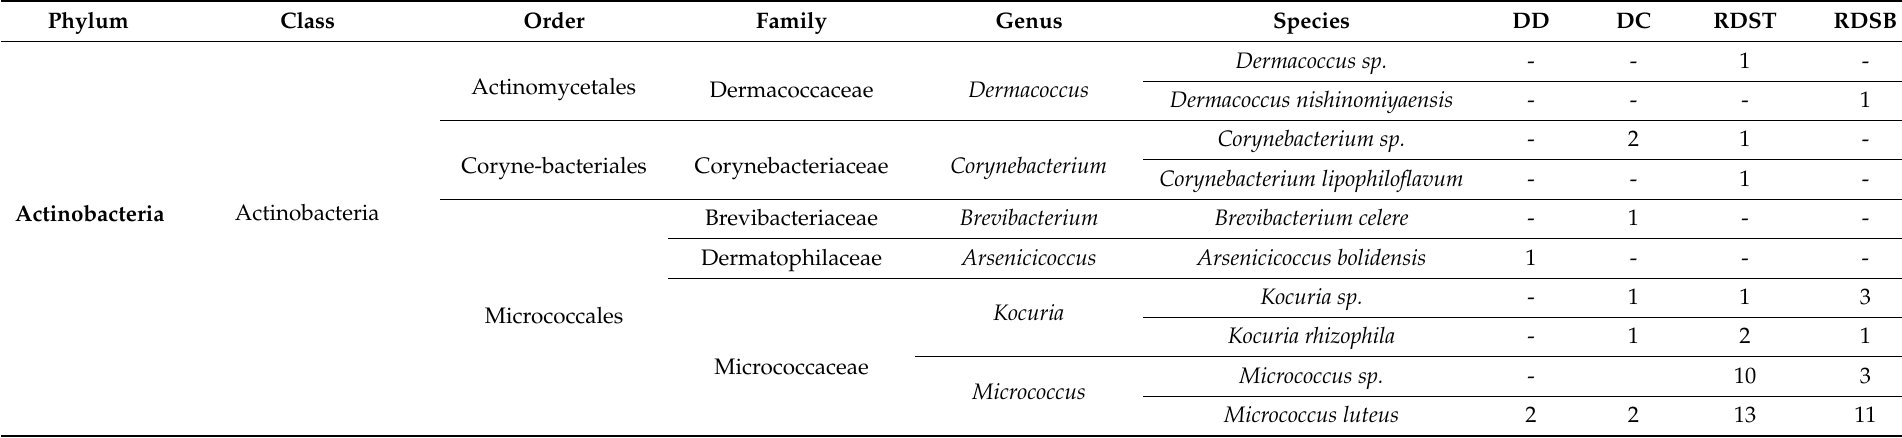
Table 1. Number of microbial isolates obtained from 10 domestic washing machines and identified by matrix-assisted laser desorption/ionization (MALDI) Biotyping with identification scores ≥ 1.7 (genus level; n = 178) and ≥ 2.0 (species level; n = 118) across the four different sampling sites (DD = detergent drawer; DC = detergent drawer chamber; RDST = top part of rubber door seal; RDSB= bottom part of rubber door seal). Species categorized as risk group 2 (based on the German Rules for Biological Agents #446 [22] and #460 [23]) are marked with an asterisk. Species detected here which have been previously identified in (9) as one of the ten relatively most abundant species from door seals and detergent drawers, respectively, are written in